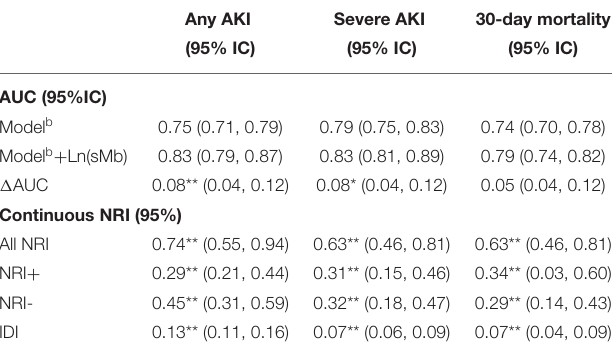
TABLE 4 | Prediction performance of the POD1